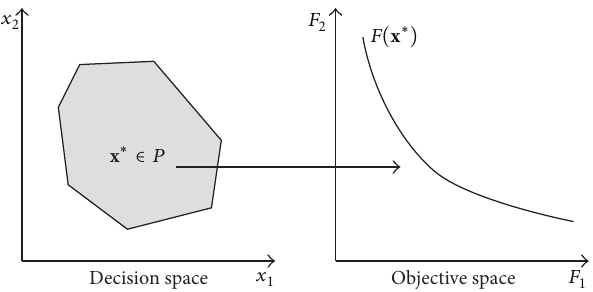
Figure 1: Representation of the decision space and the objective